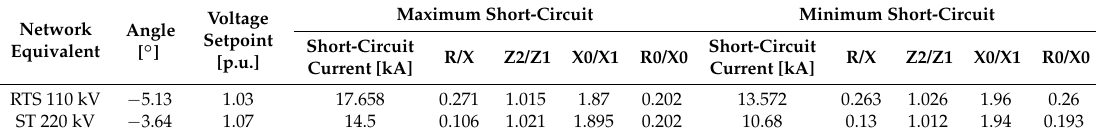
Table A6. Electrical parameters for the network equivalents used in the sample power system.